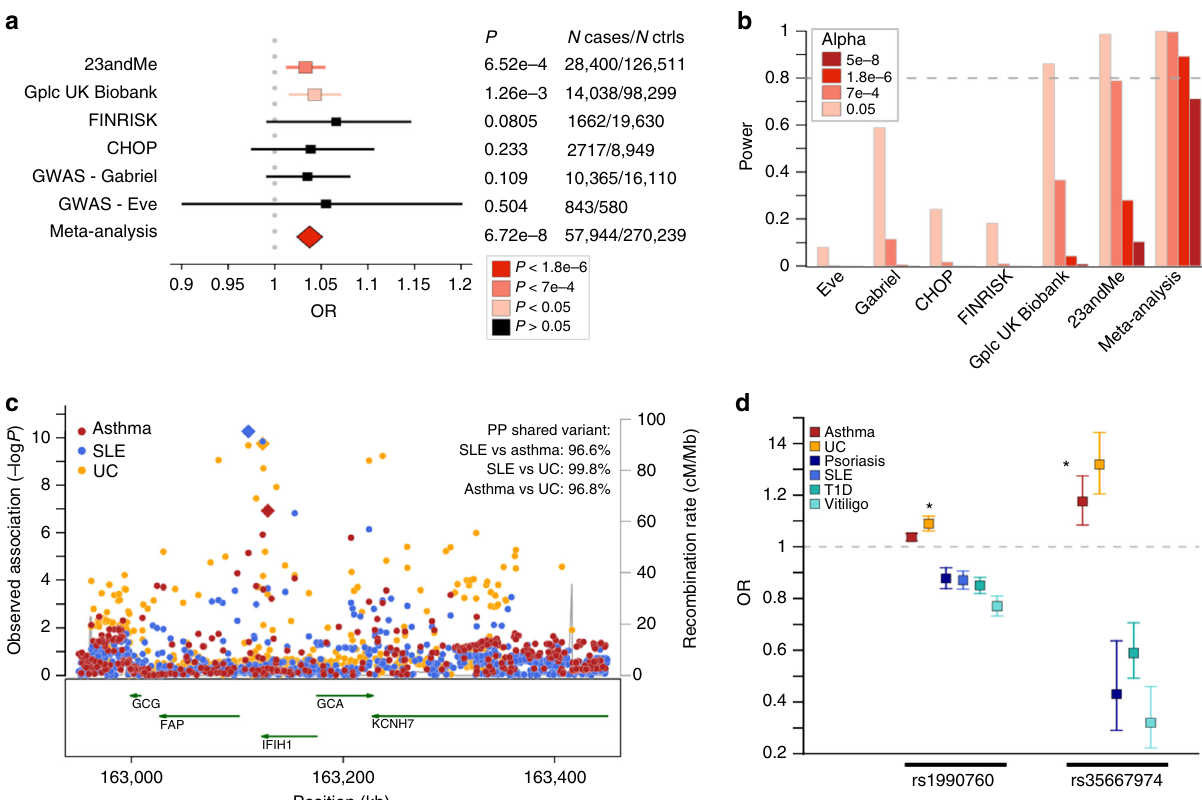
Fig. 3 Pleiotropic effects of IFIH1 LOF variants. a A signi fi cant association of IFIH1 rs1990760-C (p.T946A) with increased risk of asthma was observed in the meta-analysis of PheWAS and GWAS results, with consistent effect estimate across the six cohorts tested. Odds ratios (OR) and 95% con fi dence intervals are represented. b Power estimation demonstrates the lack of power to detect an association at rs1990760-C in currently available asthma GWAS studies. Power to surpass various signi fi cance cutoffs ( P < 0.05; FDR < 0.1, P < 7e − 4; study-wide signi fi cance after Bonferroni correction, P < 1.8e − 6; and genome-wide signi fi cance, P < 5e − 8) in the six cohorts was estimated using the frequency of the asthma risk allele (RAF = 0.39), the OR in the PheWAS/GWAS meta-analysis (OR = 1.037), a disease prevalence of 8%, and the number of cases and controls in each of the cohorts. c Co-localization analysis demonstrates that the asthma, systemic lupus erythematosus (SLE), and ulcerative colitis (UC) associations at the IFIH1 locus are driven by a shared causal signal. Regional association results with asthma (red), SLE (blue) and UC (orange) are shown. PP, posterior probability of co-localization. d Results from this study (indicated by an asterix) combined with previously published fi ndings suggest an allelic series of LOF IFIH1 alleles decreasing the risk of various autoimmune diseases while increasing the risk of asthma and UC. OR and 95% con fi dence intervals of association for the IFIH1 loss-of- function alleles rs1990760-C (p.T946A) and rs35667974-C (p. I923V) are